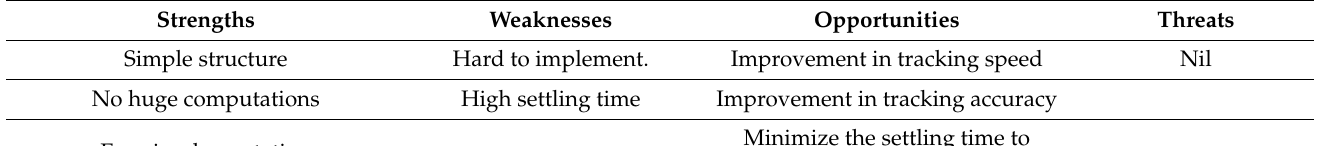
Table 1. SWOT analysis of TCA algorithm.